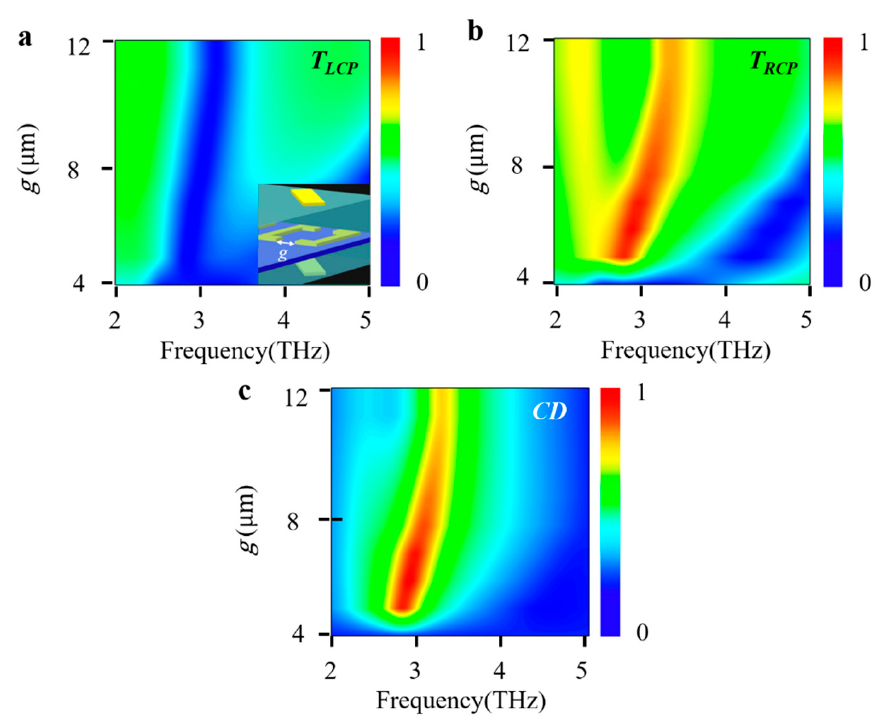
Figure 8. The calculated transmission spectra versus gap distances g for the illumination of ( a ) RCP light and ( b ) LCP light. ( c ) The calculated corresponding CD response spectra versus different gap distances g . The inset in ( a ) depicts the related geometric parameter and VO 2 is in the isolating state.